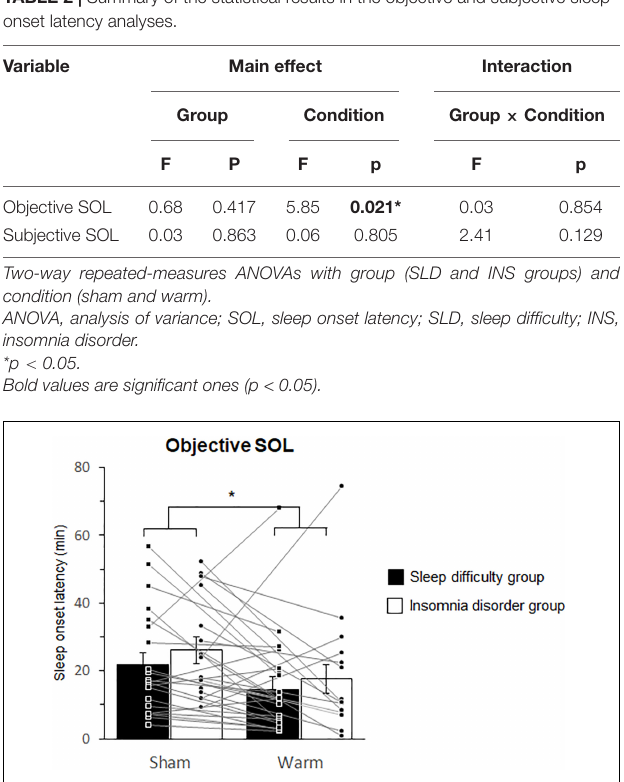
FIGURE 3 | Comparisons of the objective sleep onset latencies between the sham and warm conditions. SOL. Bars and error bars represent the mean ± standard error of the mean (SEM). SOL, sleep onset latency. * p < 0.05. between the foot and proximal skin temperatures during